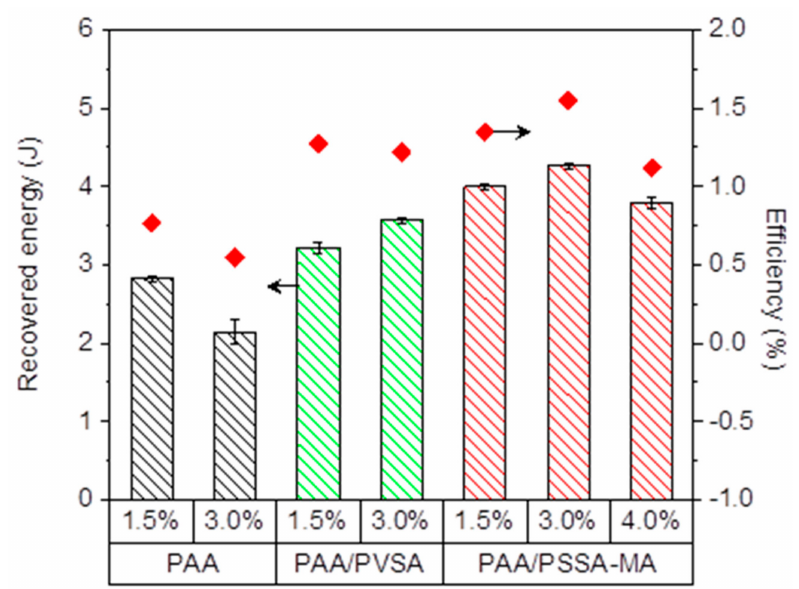
Figure 9. Recovered energy and energy efficiency as a function of crosslinker concentration of the